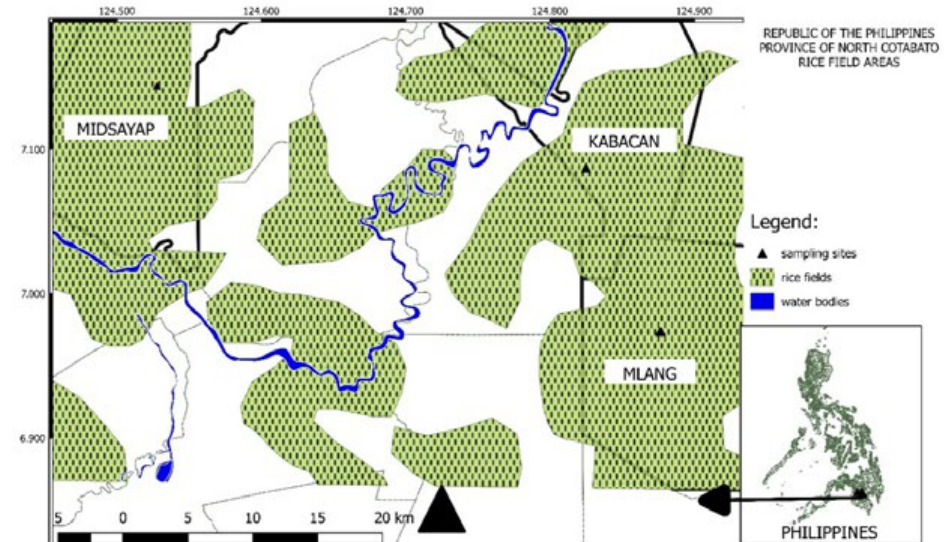
Fig. 1: Geographic location of the study area in Central Mindanao, Philippines